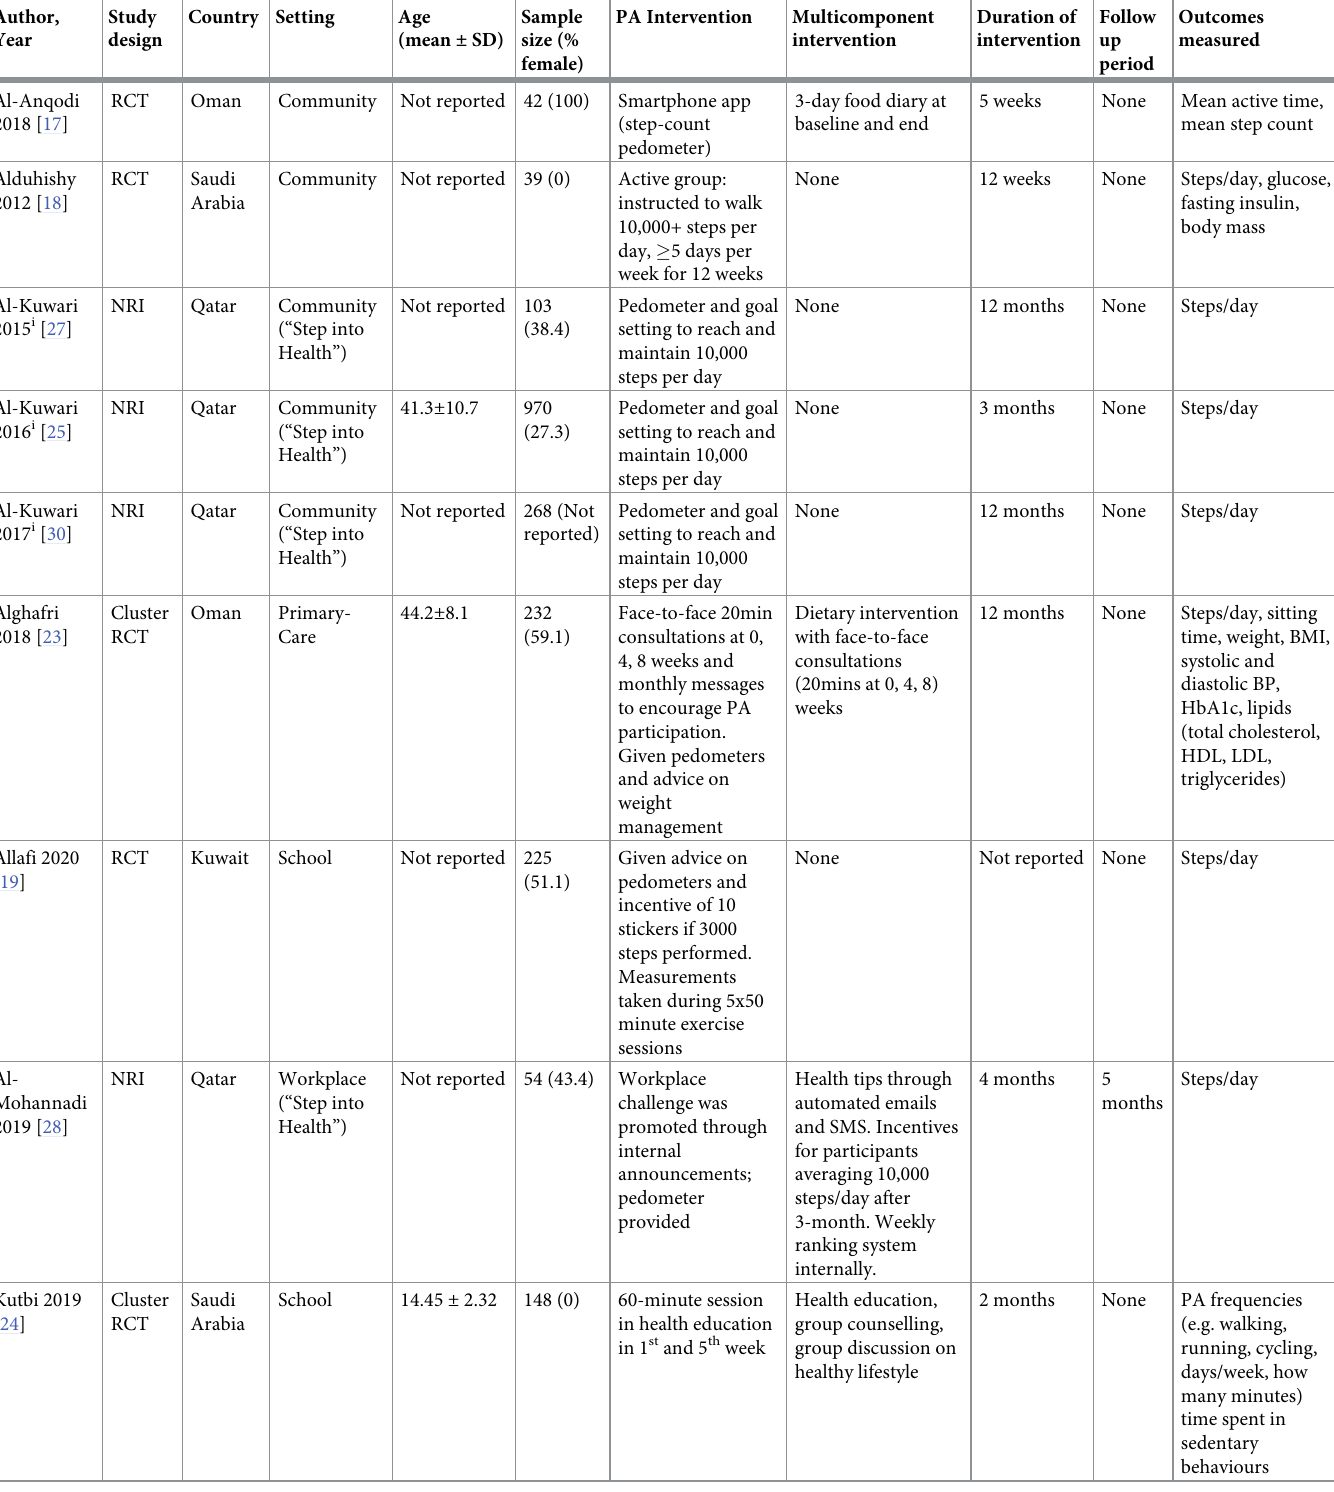
Table 1. Characteristics of the included